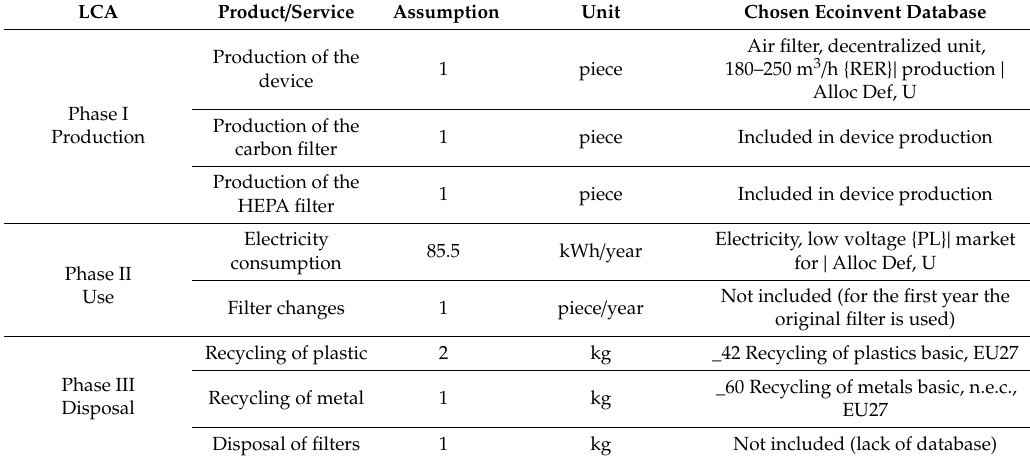
Table 3. Assumptions for LCA of air